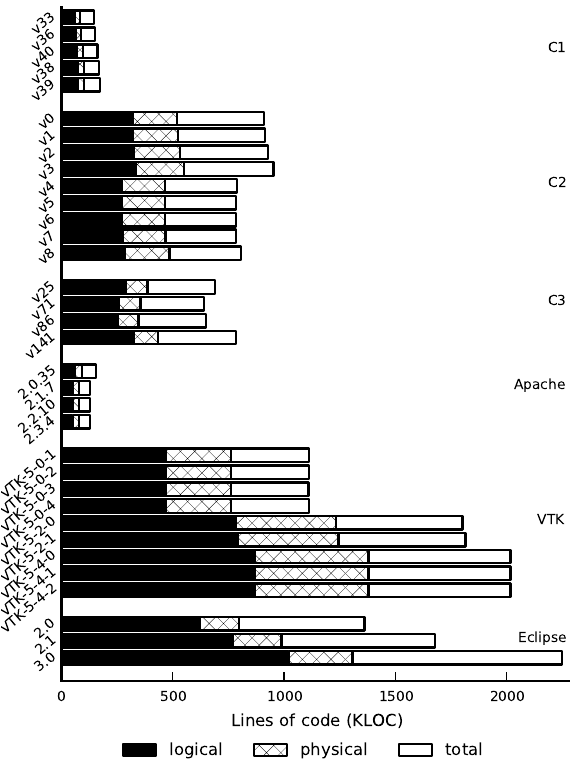
Fig. 3. Lines of code measurements for each project.